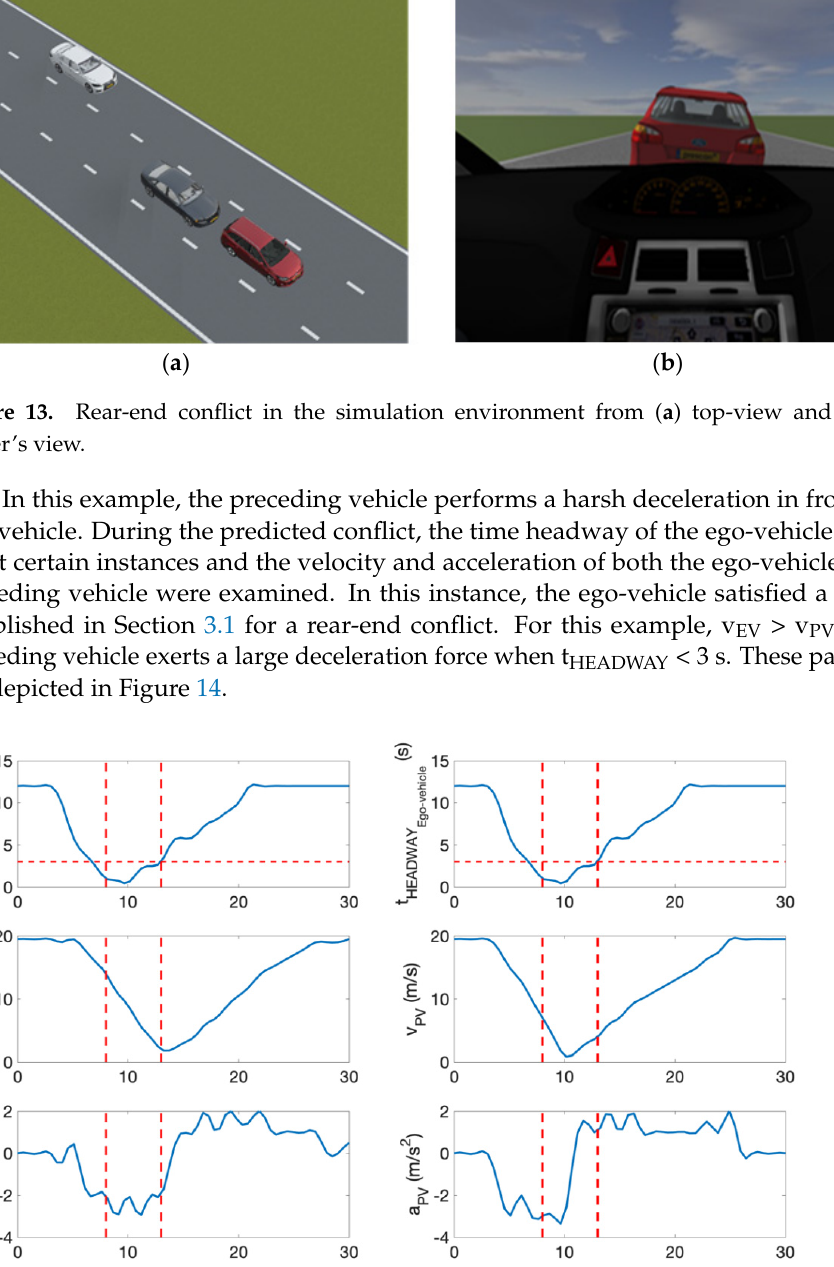
( b ) Figure 15. Lane change conflict in the simulation environment from ( a ) top-view and from ( b ) driver’s view. In this example, the lane changing vehicle changes lane abruptly in front of the ego- vehicle. Similarly, during the predicted conflict, the time headway of the ego-vehicle is also below 3 s at certain instances. The velocity and acceleration of both the ego-vehicle and the preceding vehicle were examined. Following the criteria in Section 3.1, these cri- teria were also met. For this example, a EV > v PV , a EV ↑ when t HEADWAY < 3 s. Some of the parameters were depicted in Figure 16. It is also important to note that the criterion of s LONGITUDINAL < 75 m was met throughout this whole example.